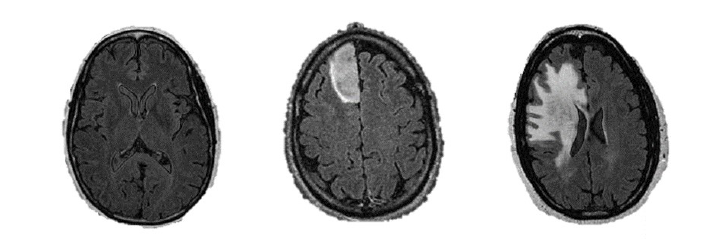
Figure 1. Magnetic Resonance Imaging (MRI) of healthy subject, low-grade and high-grade glioma